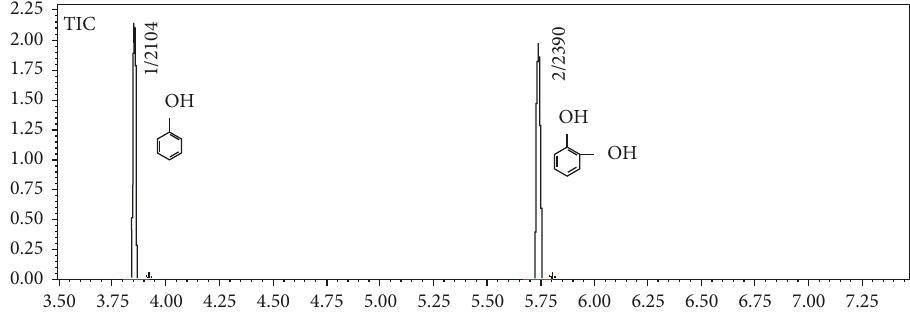
Figure 8: GC-MS test of phenol hydroxylation over Fe(II)/MOF-5 (3%).